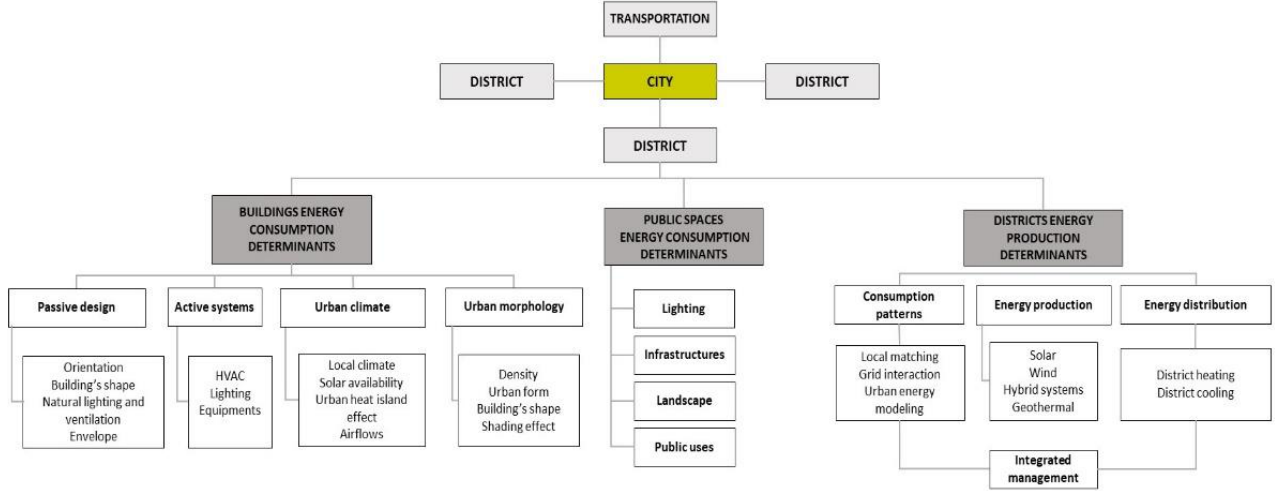
Figure 1. Energy determinants implied in each scale, focusing on the district balance towards an NZED. Reproduced with permission from [7], Elsevier, 2018.